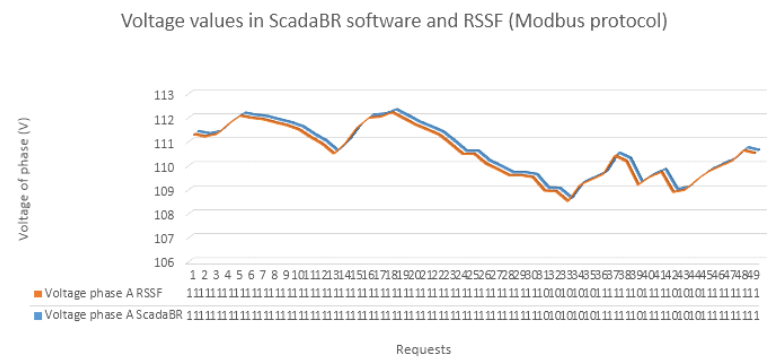
Figure 7. Comparison between the readings performed by ScadaBR and the sink node on the